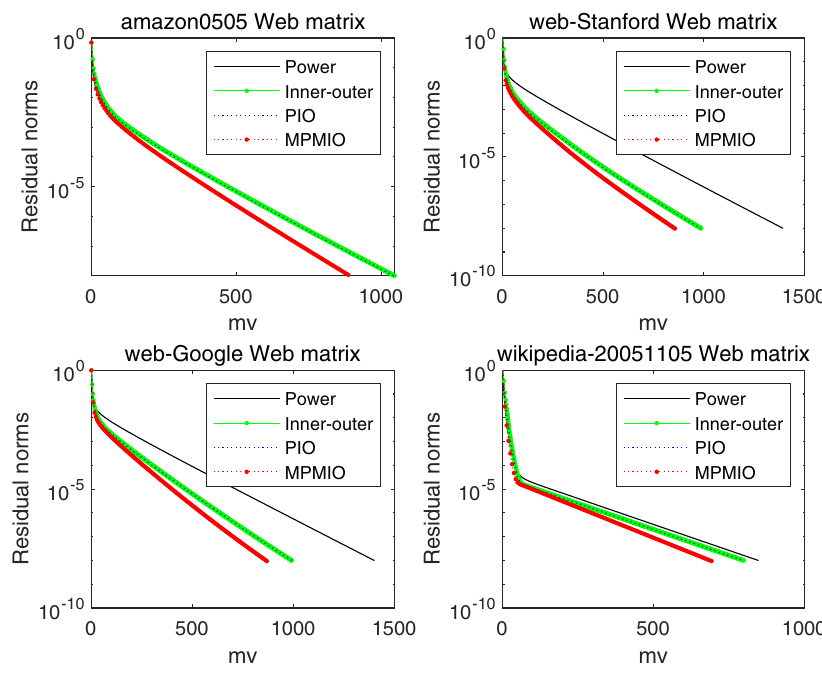
Figure 1: Convergence of the computation for the four Web matrix.